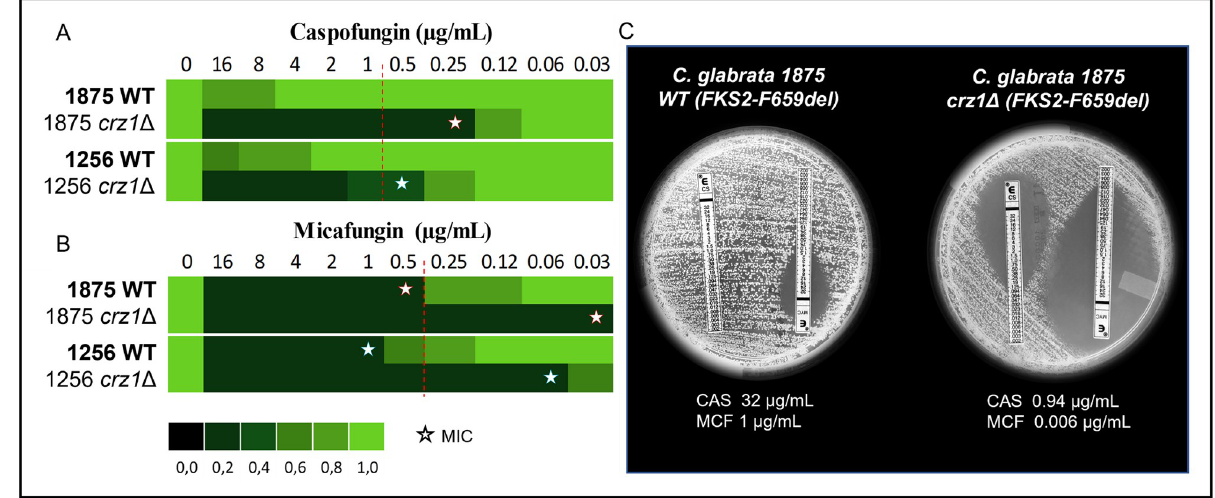
Fig 2. Susceptibility determination. (A) Caspofungin (B) Micafungin, minimal inhibitory concentration (star) by broth microdilution method. The green colour bar represents relative growth. Dotted red line indicates cut-off values (C) Caspofungin (CAS) and micafungin (MCF) Etest determination using RPMI agar supplemented with 2% glucose. The 10 6 cell/mL yeast suspensions were spread on RPMI agar plates, MIC readings were made following 24 h incubation at 35 ˚C. The MIC was read as the drug concentration that leads to 80% of inhibition.